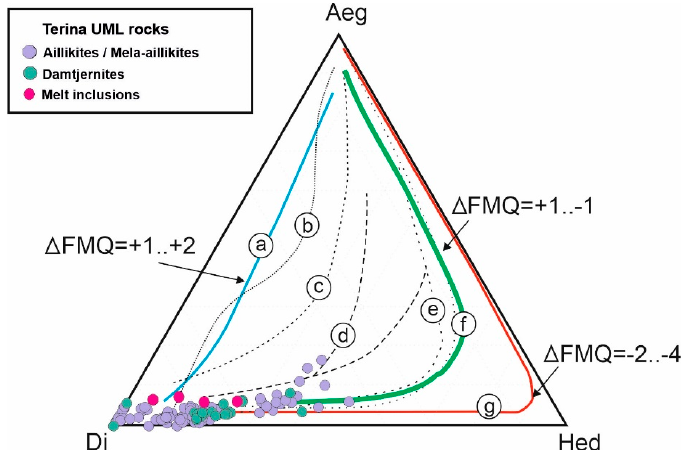
Figure 4. Clinopyroxene evolution trends of various alkaline complexes in the world according to [34]: ( a ) Katzenbuckel, SW Germany [34]; ( b ) Murun, Russia [35]; ( c ) Lovozero, Russia [36]; ( d ) Alnö, Sweden [37]; ( e ) Coldwell nepheline syenites, Canada [38]; ( f ) North Q ộ roq, South Greenland [39]; ( g ) Il ί maussaq, South Greenland [40]. Quantitative data on oxygen fugacity (given as Δ FMQ units, where FMQ is the fayalite-magnetite-quartz buffer) imply that the chemical evolution of clinopyroxene might be useful as a qualitative indicator of oxygen fugacity. The clinopyroxene compositions of the Terina UML rocks show the position around the FMQ buffer.